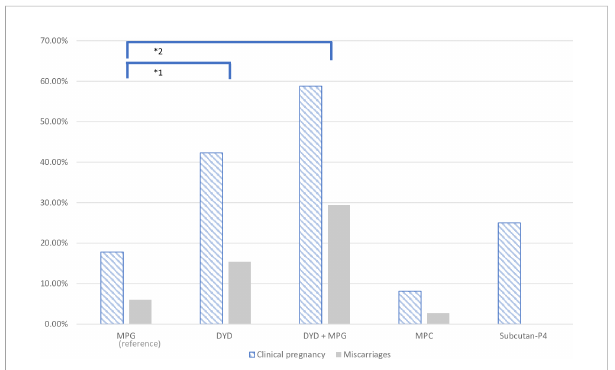
FIGURE 2 Graphical representation of clinical pregnancy and miscarriage rate in the fi ve progesterone